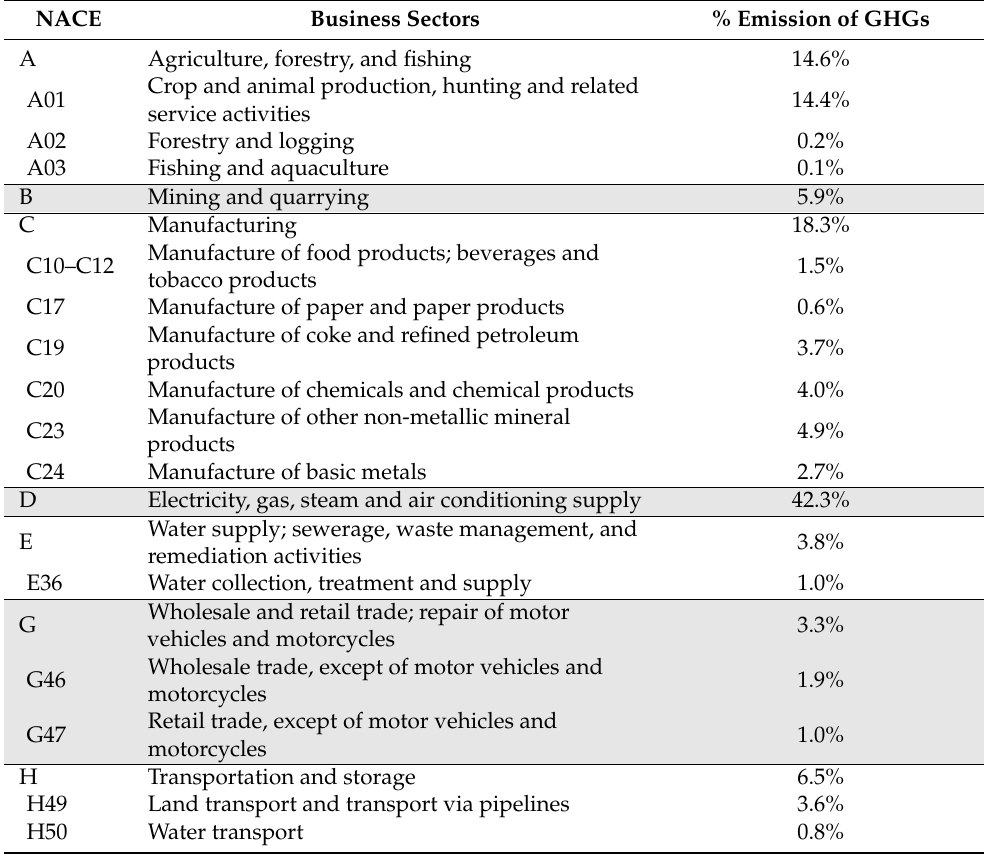
Table 1. Emission sectors in